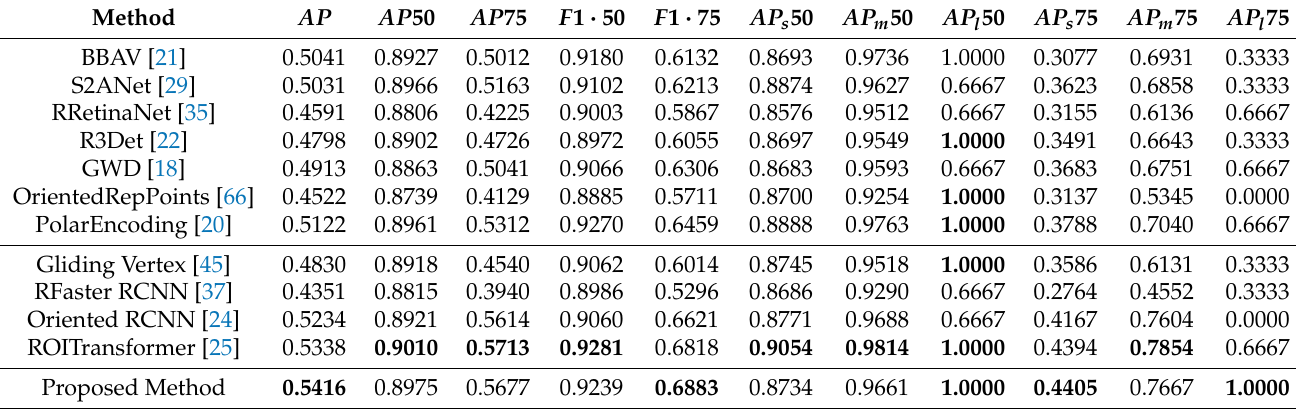
Table 8. Quantitative Results on